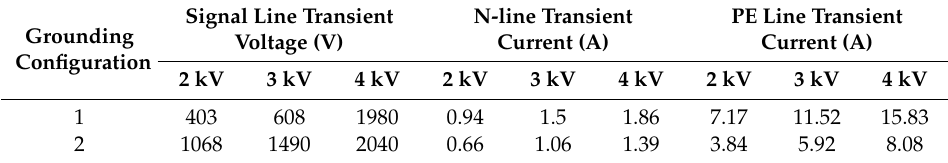
Table 4. The interference of each test point of the ECT acquisition card applying 100 kHz EFT / Bs. Grounding